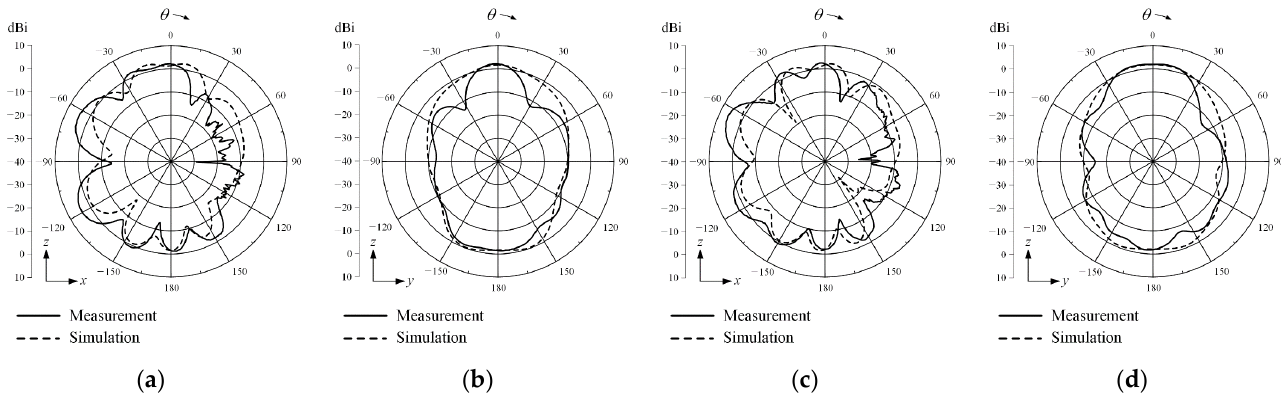
Figure 6. Measured and simulated bore-sight gains of the proposed antenna with and without parasitic elements.